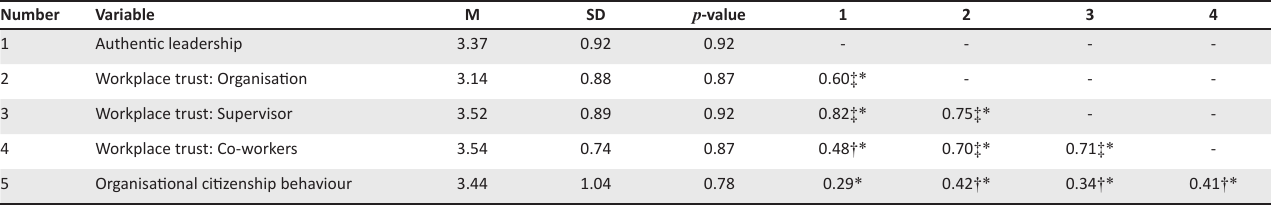
TABLE 4: Correlation matrix including reliabilities, means and standard deviations. Number Variable